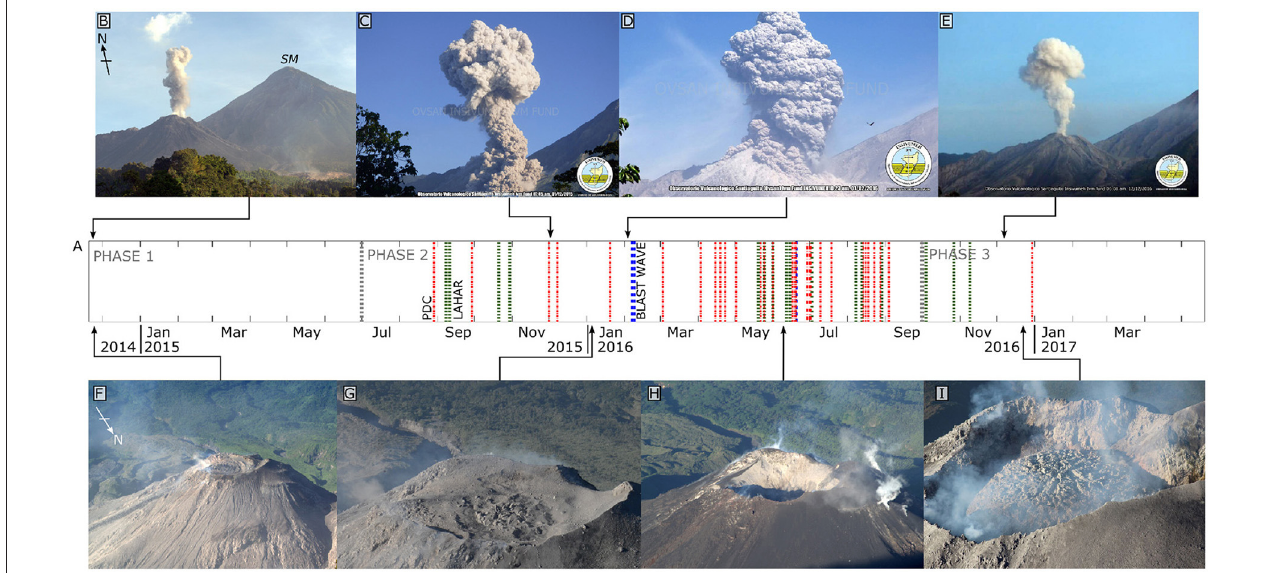
FIGURE 2 | (A) Timeline of activity at Santiaguito dome complex between November 2014 and May 2017. Gray dashed lines separate different phases of activity. Red dashed lines indicate explosions accompanied by pyroclastic density currents (PDCs). Green dashed lines indicate reported major lahars. Blue dashed lines indicate explosions accompanied by reported blast waves. (B–E) Images of explosions during this period. Images (C–E) were kindly provided by INSIVUMEH, and all images were captured at or near the old OVSAN building, looking NNE (OVSAN in Figure 1 ). For scale, the height difference between the vent and the summit